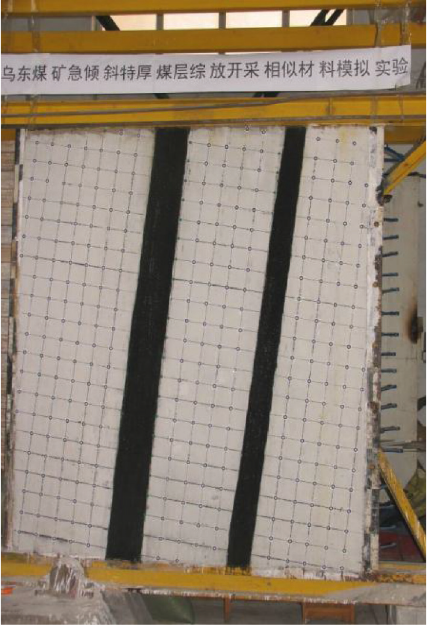
Figure 2: Overall effect of a similar material simulation